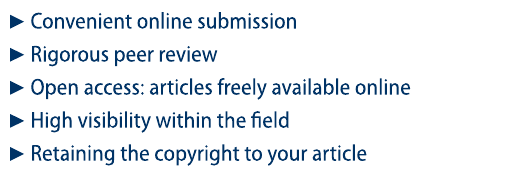
Table C-2. Hay fever, respiratory allergies, food allergies, and skin allergies in the past 12 months for children under age 18 years, by selected char- acteristics: United States, 2015. https:// ftp. cdc. gov/ pub/ Health_ Stati stics/ NCHS/ NHIS/ SHS/ 2015_ SHS_ Table_C- 2. pdf. Accessed 21 Nov